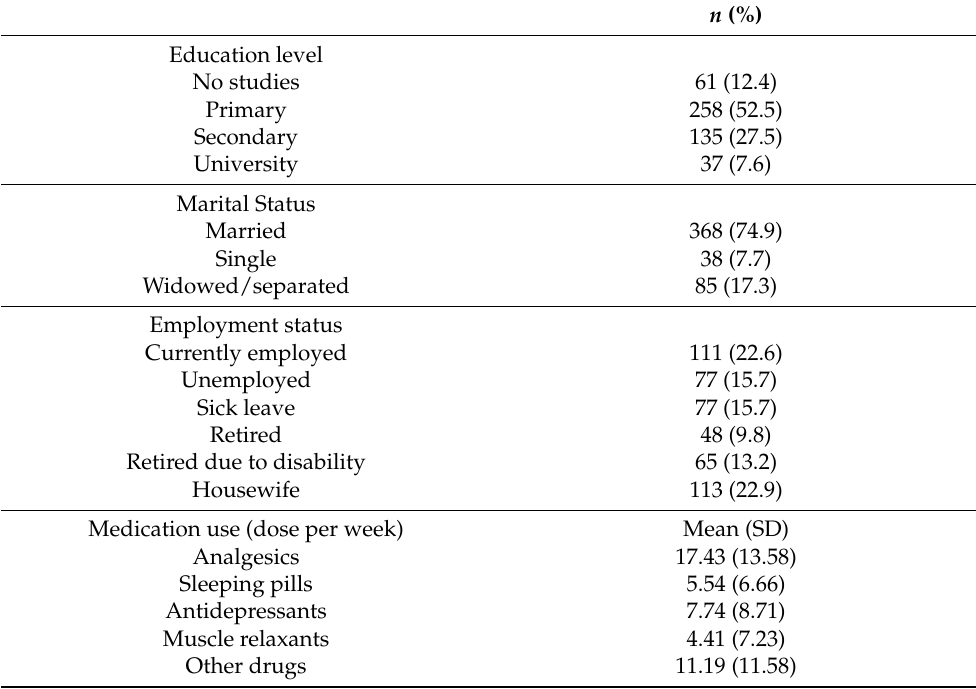
Table 1. Sociodemographic and clinical data of the sample ( n =